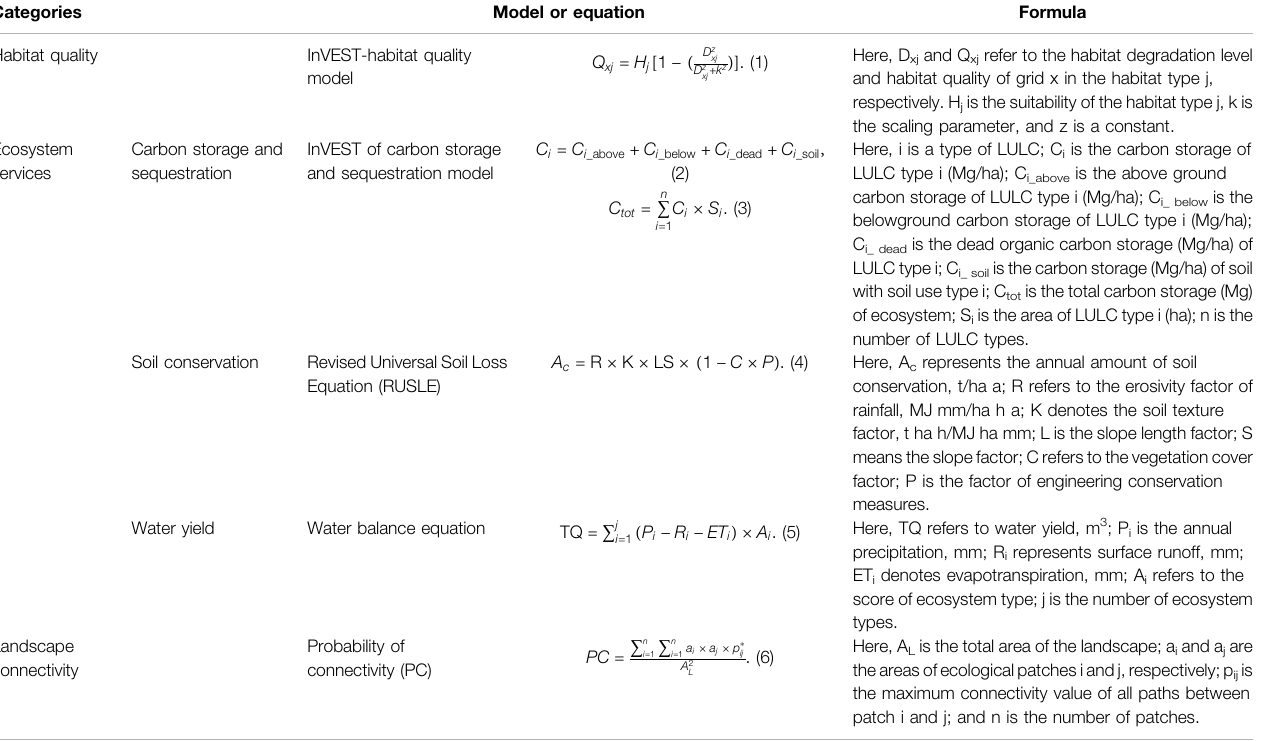
TABLE 1 | Methods to assess habitat quality, ecosystem services, and landscape connectivity for ecological